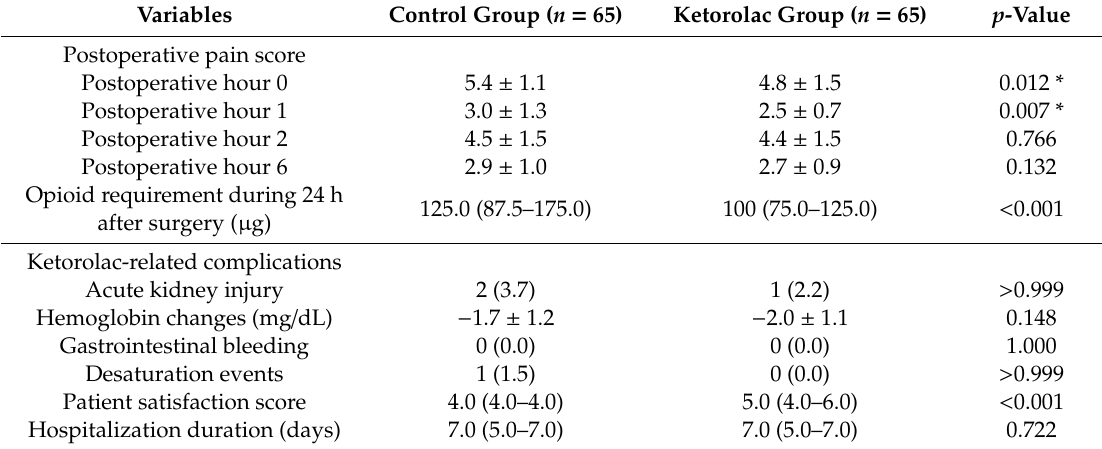
Table 3. Postoperative pain score, opioid requirement, ketorolac-related complications, patient satisfaction score, and hospitalization duration in patients undergoing robot-assisted laparoscopic radical